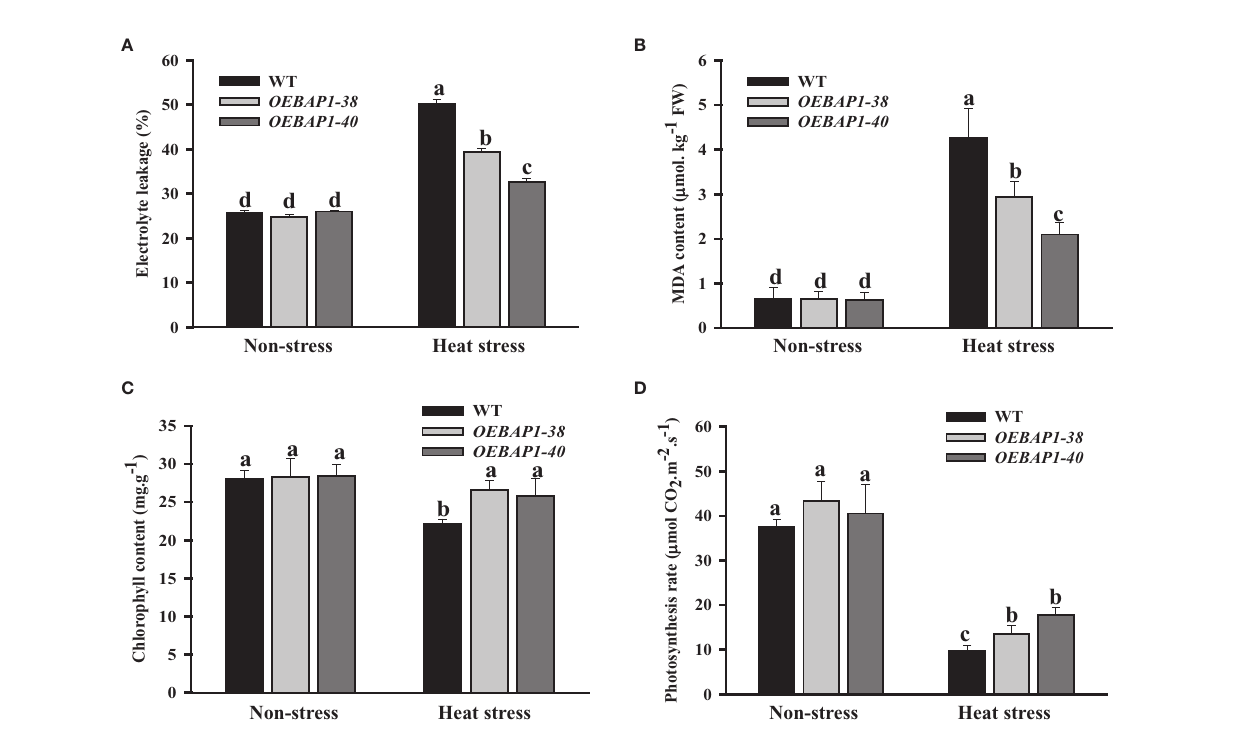
FIGURE 3 | Analysis of physiological indexes of VvBAP1 -overexpressing Arabidopsis under heat stress. The electrolyte leakage (A) , MDA content (B) , chlorophyll content (C) , photosynthetic rate (D) in the leaves of overexpressing lines under heat stress (45°C for 2 h). Each experiment was conducted thrice. Values are the means ± SE of three independent experiments ( P < 0.05). Lower-case letters above bars denote signi fi cant differences attested by Tukey ’ s HSD